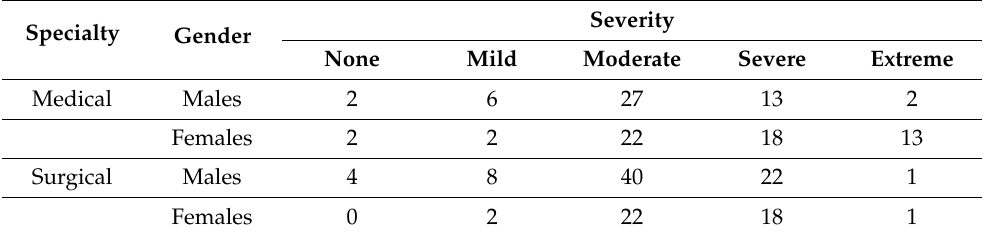
Table 2. Psychological impact of working in a COVID-19 unit.